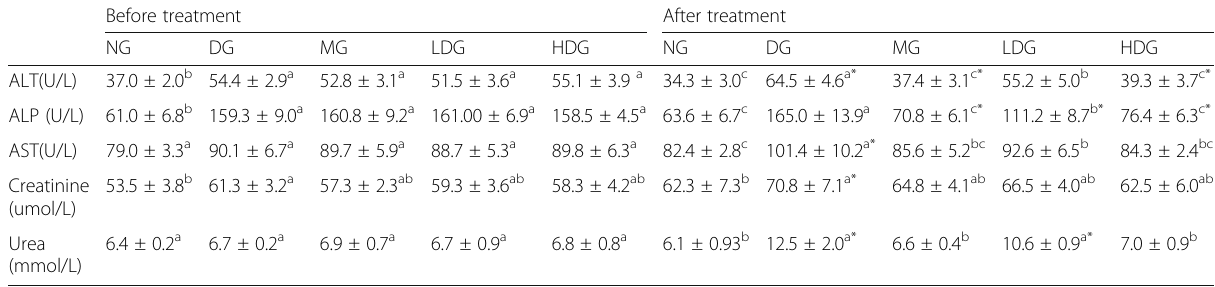
Table 1 The body weights, serum alanine aminotransferase (ALT), alkaline phosphatase (ALP) aspartate aminotransferase (AST), creatinine and urea levels before and after treatment Before treatment After treatment